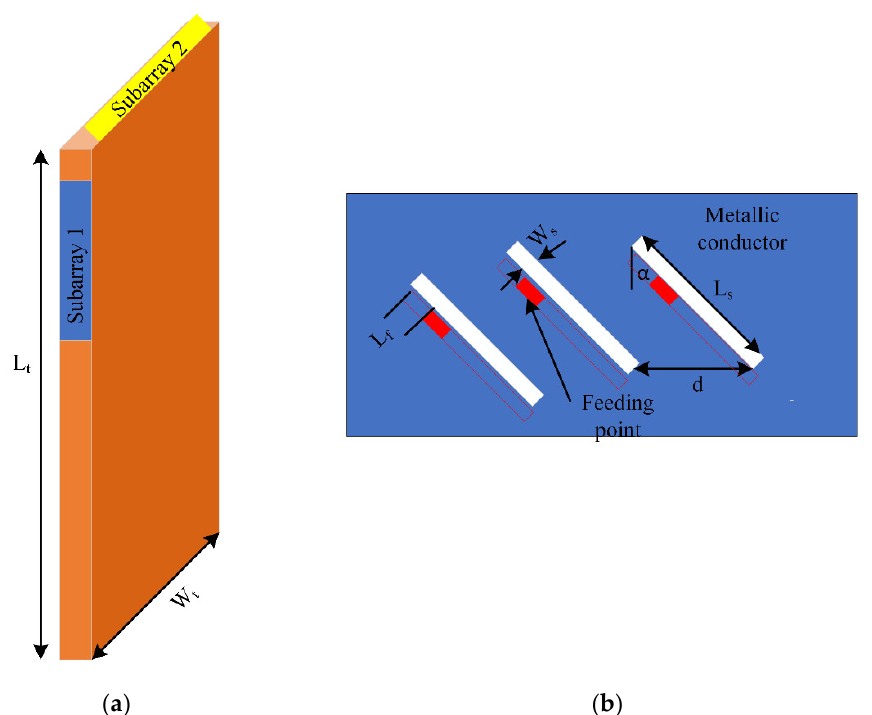
Figure 5. Beam steering idea for talking and browsing modes; the idea behind the figure has been brought from [7].